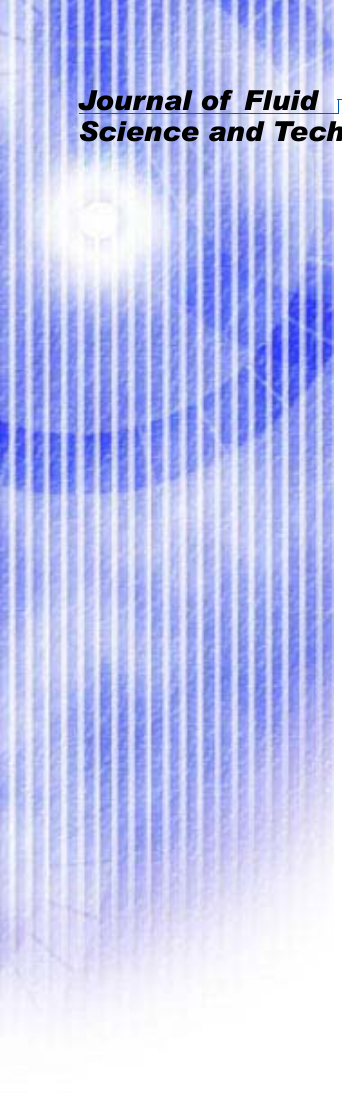
Full-scale Q * m (Electric